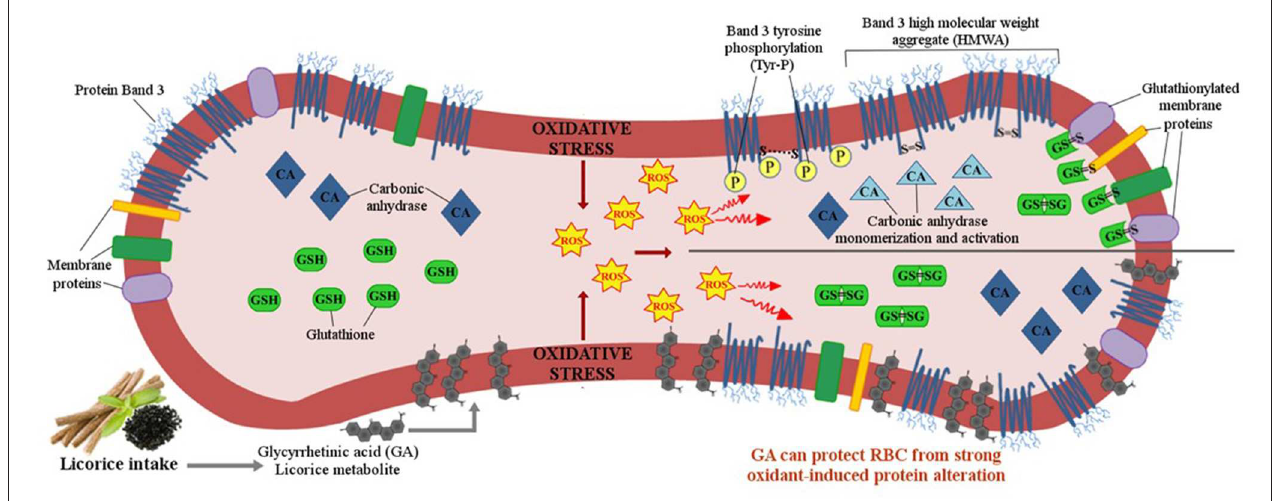
FIGURE 3 | Red blood cell (RBC) membrane alterations induced by oxidative stress and the possible anti-inflammatory effect of licorice. Glycyrrhetinic acid (GA), which has been shown to directly interact with membrane sphingolipids and cholesterol, can induce a protective shield against membrane protein oxidation, mainly avoiding protein band 3, the main constituents of RBC membranes, from being oxidized by ROS to form high molecular weight aggregate (HMWA), recognized by circulating IgG as premature aged cells. GA also prevents protein glutathionylation, which would avoid cytosolic GSH store depletion and support the correct functioning of cytosolic enzymes such as Carbonic Anhydrase